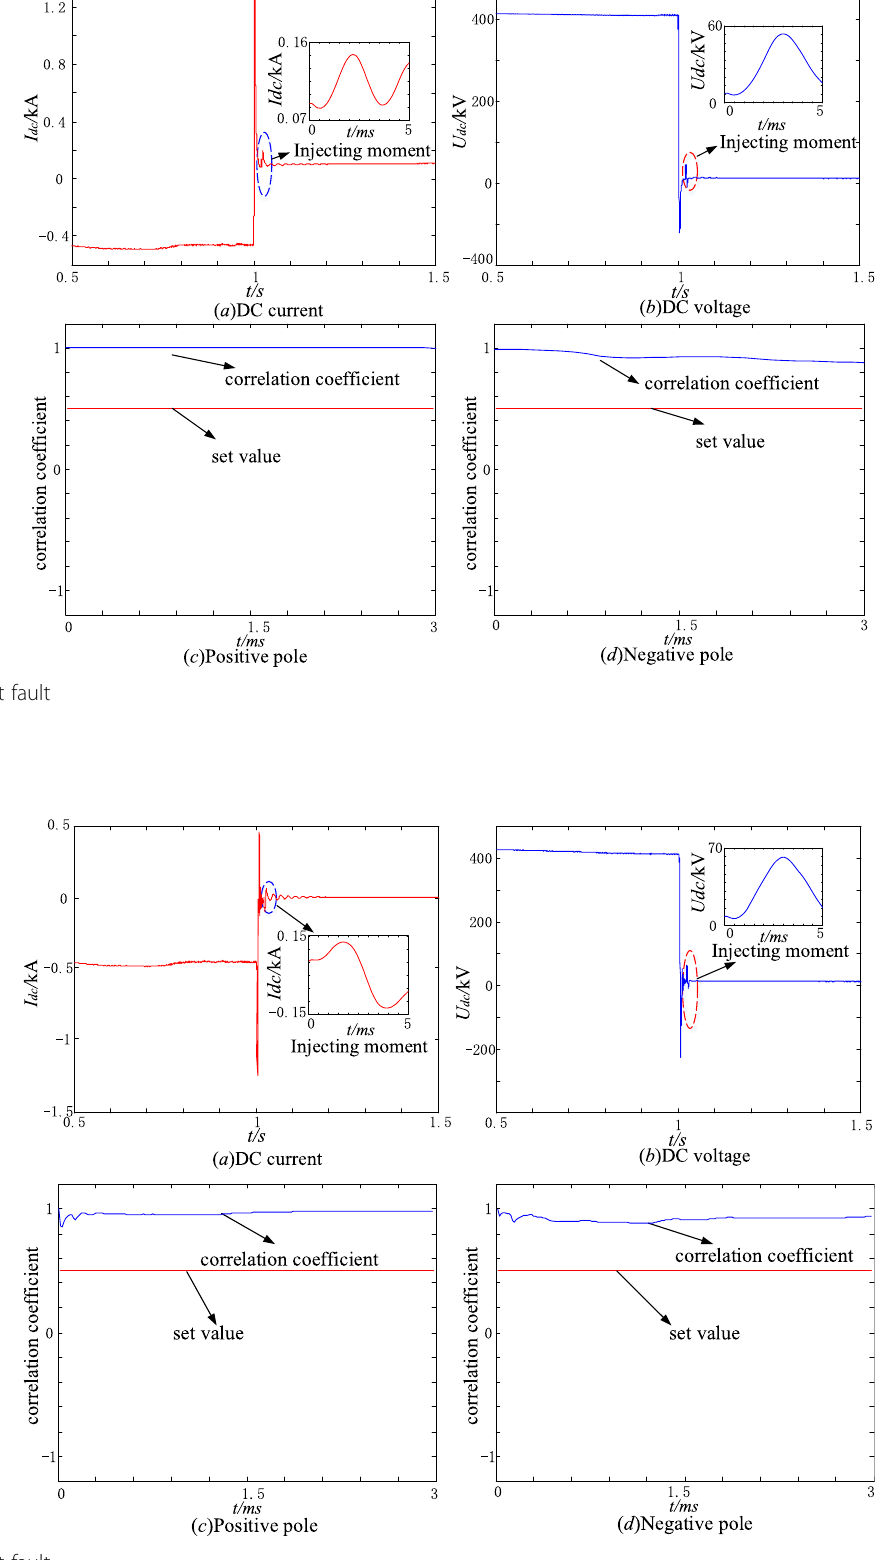
Fig. 14 f 3 point